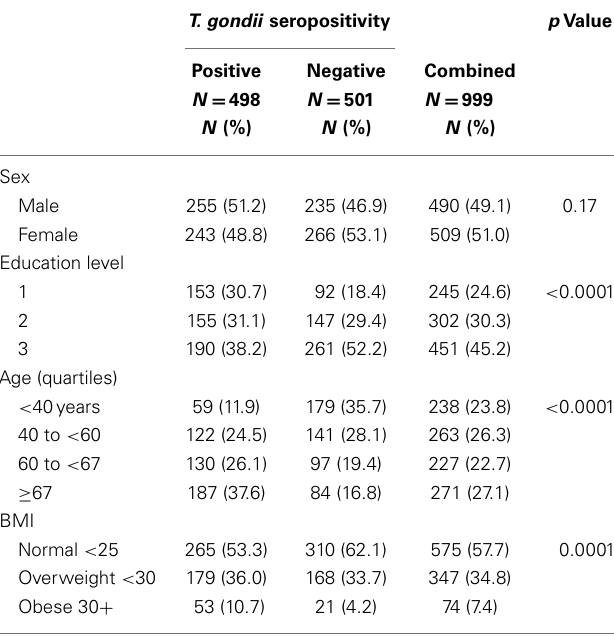
Table 1 | Demographics of study sample.